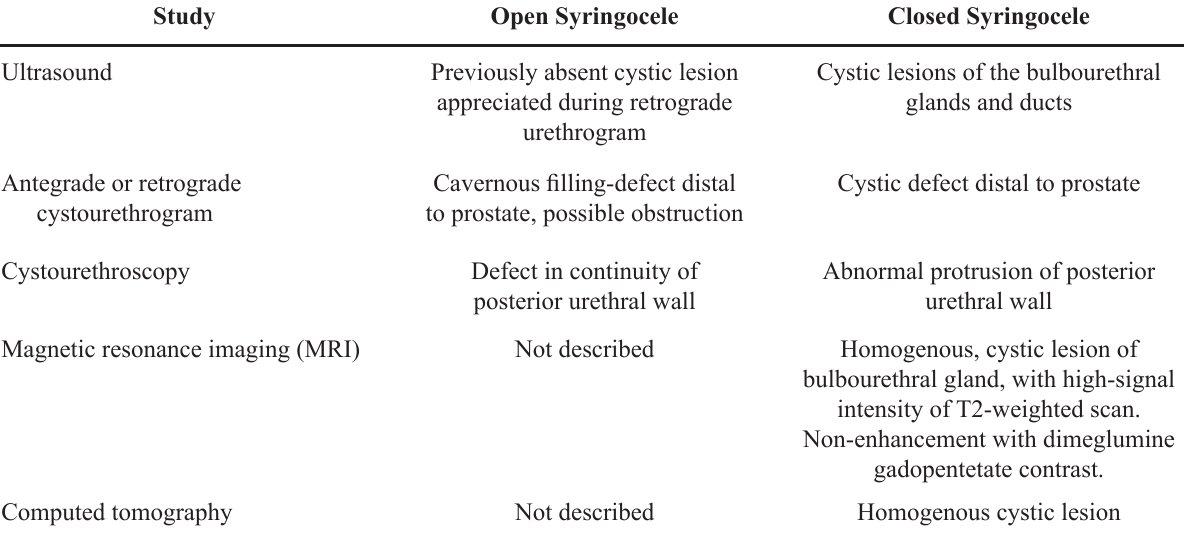
Table 2 – Indications for radiologic-interventional studies to diagnose